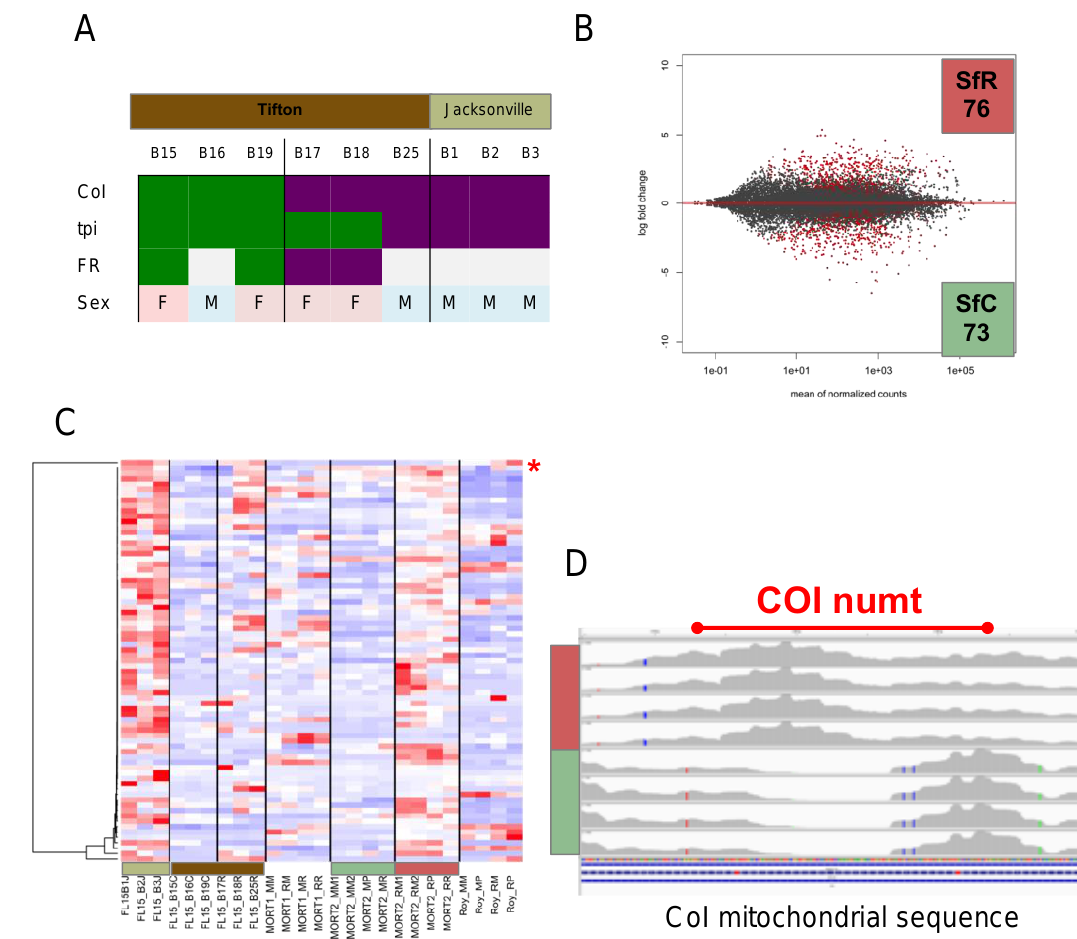
Figure 4: RNA-Seq of individual larvae from the fields. (A) Genotypes of the individual L4 larvae from natural populations used for RNAseq studies. CoI, tpi and FR1 repeat genotyping has been done by PCR- RFLP (Supplementary Figures 8-10). Color code is dark green for presumptive C-strain genotype according to the literature while purple is for presumptive R-strain genotypes. Sex has been determined post-facto by examining the alignments of reads on the Z-associated tpi locus. If all SNP positions within the scaffold are homozygous, we assumed the individual was female. Heterozygosity indicates a male. (B) Multidimensional scaling plot (MA-plot) reporting the log2 fold changes between the strains (sf-R vs sf-C) over the mean of normalized counts when combining FL15 and MORT2 experiments. Each dot represents a gene either with a non-significant differential expression between conditions (gray dots) or with a significant differential of expression (red dots). 76 genes are overexpressed in sf-R and 73 in sf-C. (C) Heatmap of expression variations (expressed as z-scores) of the sf-R specific expressed genes across all RNAseq experiments. For each gene, red indicates a higher expression and blue a lesser expression across the experimental dataset. Genes have been hierarchically clustered as indicated by the dendrogram on the left by similarity of expression variation. The red asterisk identifies the COI-numt expression. (D) View of the mitochondrial genome corresponding to the COI-numt sequence and alignment coverage of reads corresponding to sf-R (red) or sf-C (green) samples of the MORT2 experiment. We can observe a trough of expression in this region associated with sf-C